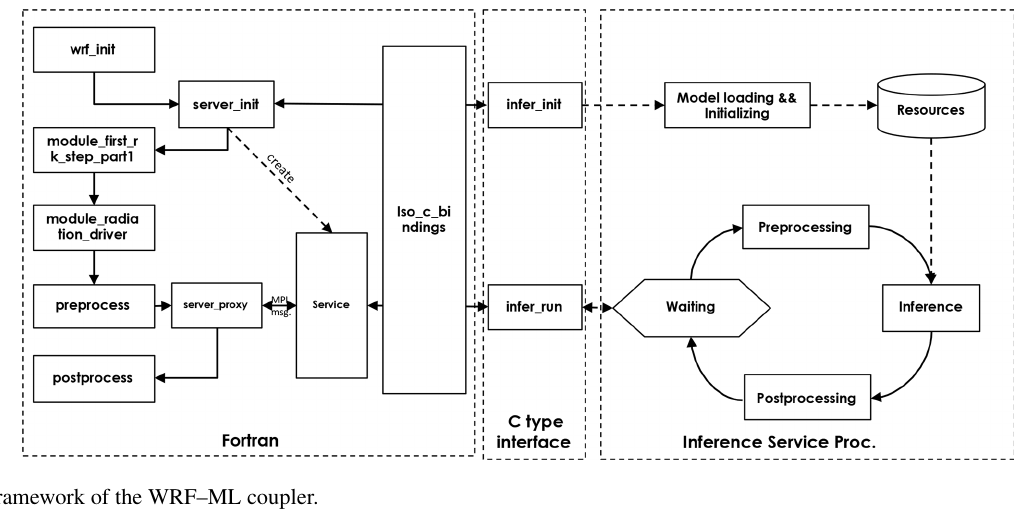
Figure 3. Framework of the WRF–ML coupler.